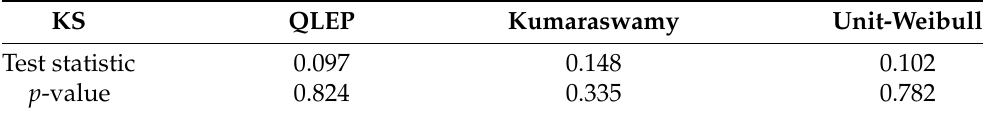
Table 4. KS test results for the rqrs of the